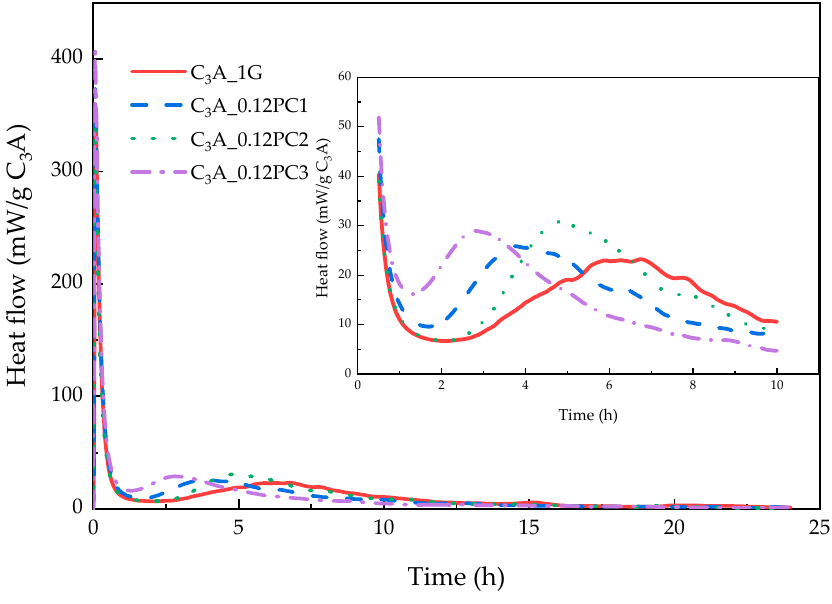
Figure 10. Heat evolution curves of C 3 A-gypsum with a 0.12% concentration of different kinds of PCs solution during the 24-h hydration.